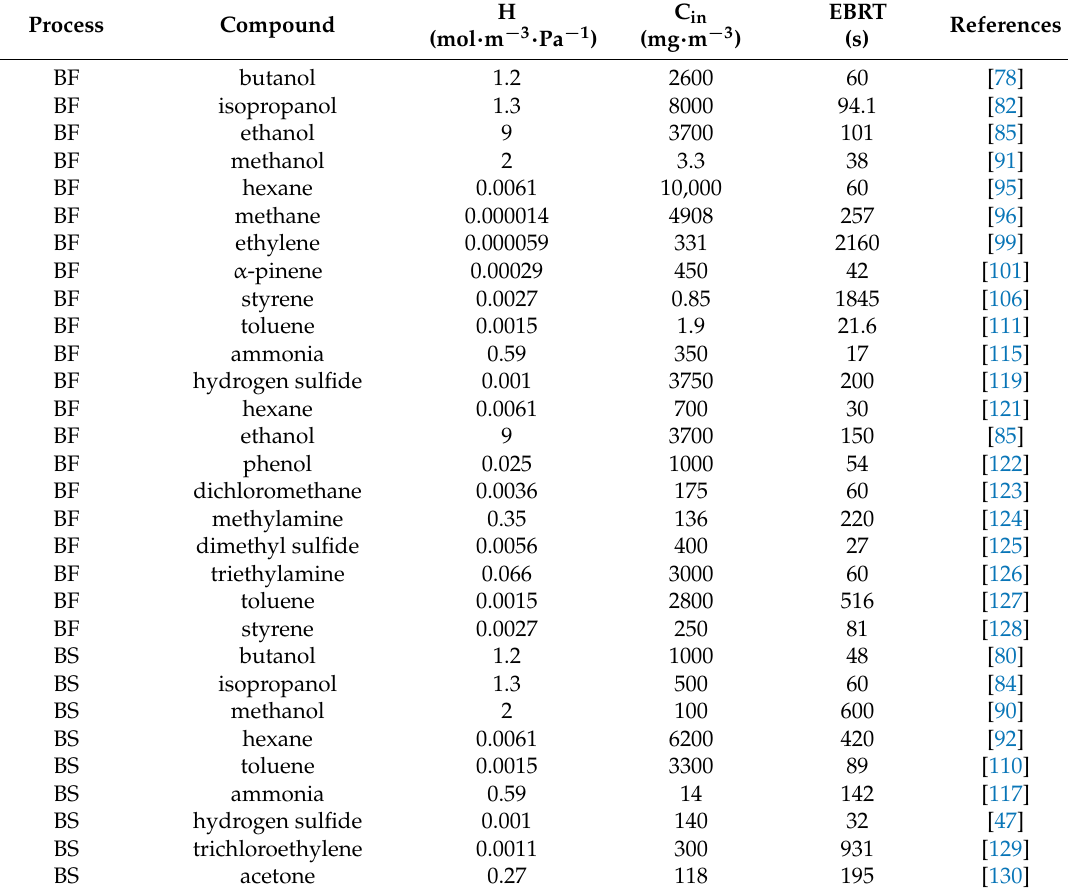
Table 5. Data set used for the decision tree